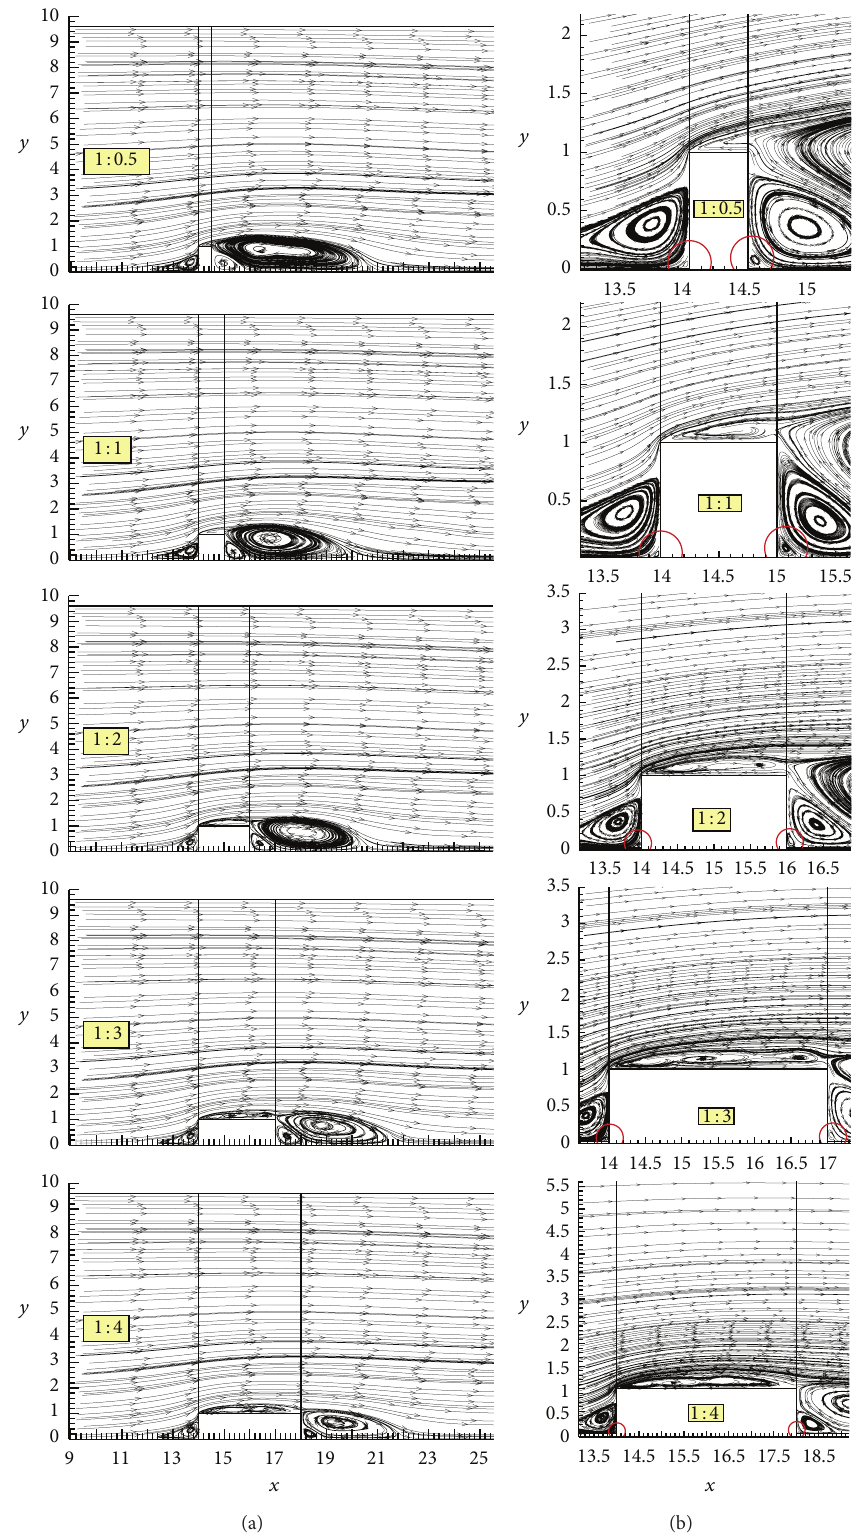
Figure 3: Mean streamline patterns for the five different rib aspect ratios (a) and zoomed-in averaged flow patterns in the neighborhood of the ribs both upstream and downstream